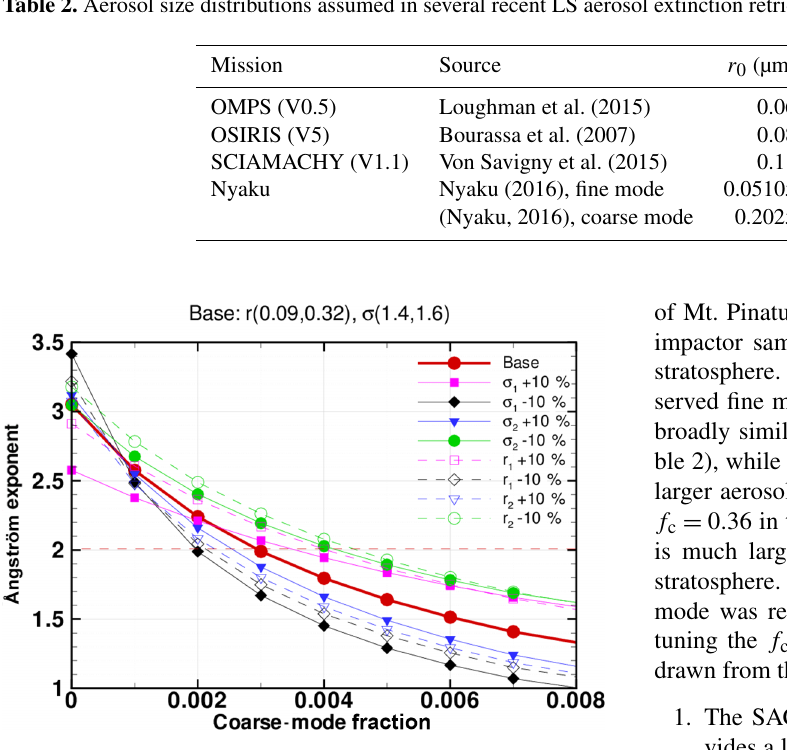
Figure 8. Variation of Ångström exponent α( 525 / 1020 ) with aerosol properties for the V1 OMPS LP aerosol extinction re- trieval algorithm characteristics. Each curve shows the variation of (α( 525 / 1020 ) with f c for a given set of median radii and mode widths. In addition to the “base” curve (which uses the V1 char- acteristics listed in Table 1), several curves show how the value of α( 525 / 1020 ) changes as the values of r 1 ,σ 1 ,r 2 , and σ 2 (in Table 1) are perturbed by ±